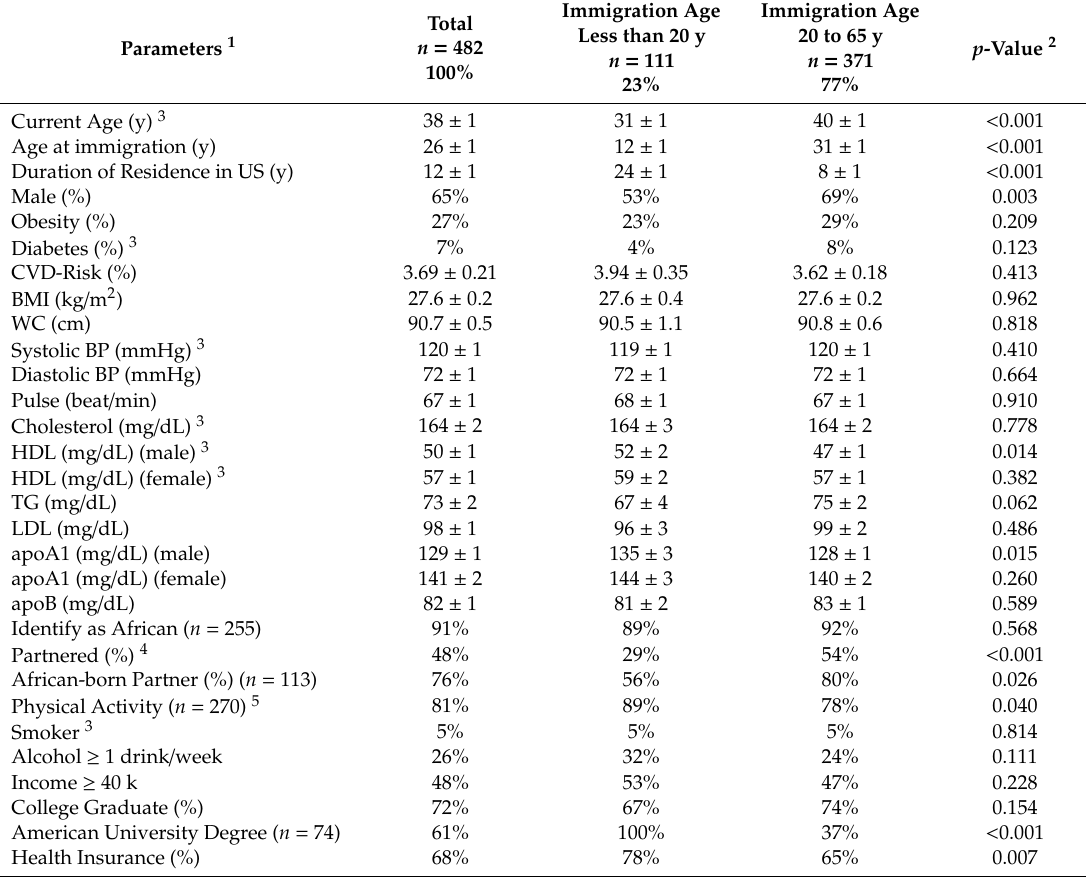
Table 1. Characteristics by Immigration Age